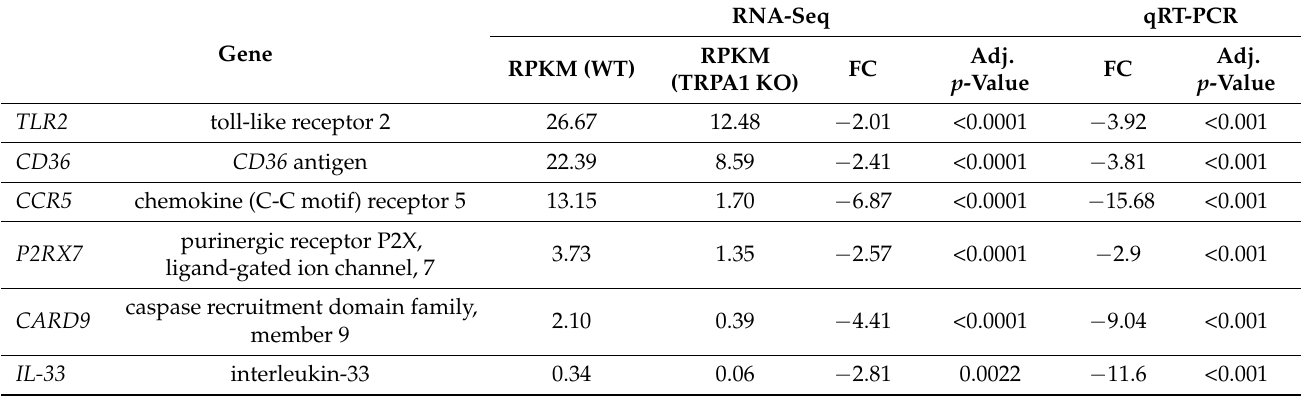
Table 2. Genes putatively explaining the differential expression of IL-6 production according to RNA-Seq analysis was performed on IL-1 β -treated chondrocytes obtained from TRPA1 deficient (KO) and corresponding wild-type (WT) mice. Gene expression levels are given as RPKM. Differences between the genotypes are given as fold change (FC) values, with negative Gene Ontology (GO) analysis. values indicating downregulated genes in chondrocytes from TRPA1 KO mice. The p -values are adjusted by false discovery rate (FDR). The RNA-Seq results were verified by qRT-PCR, where p -values are given as Bonferroni-adjusted; FDR—false discovery rate,